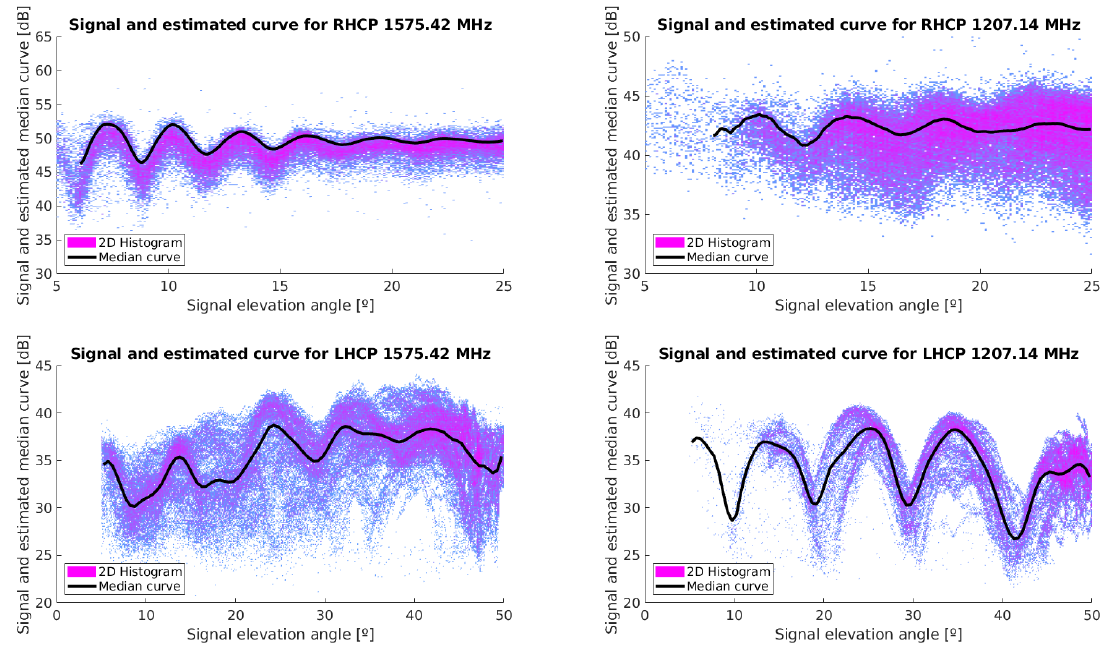
Figure 11. 2D histograms (density plot) and median curve (in black) for the received signals in GPS L1 C/A, Galileo E1C, Galileo E5b, and Beidou B2D1.